Question: Sum up the contents of this chart in one sentence.
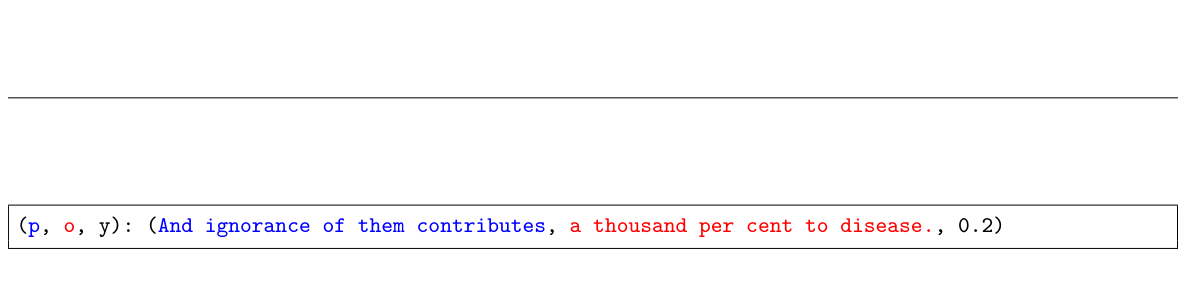
Answer: Example datapoint (prompt, output, constraint score) using synthetic data generation algorithm